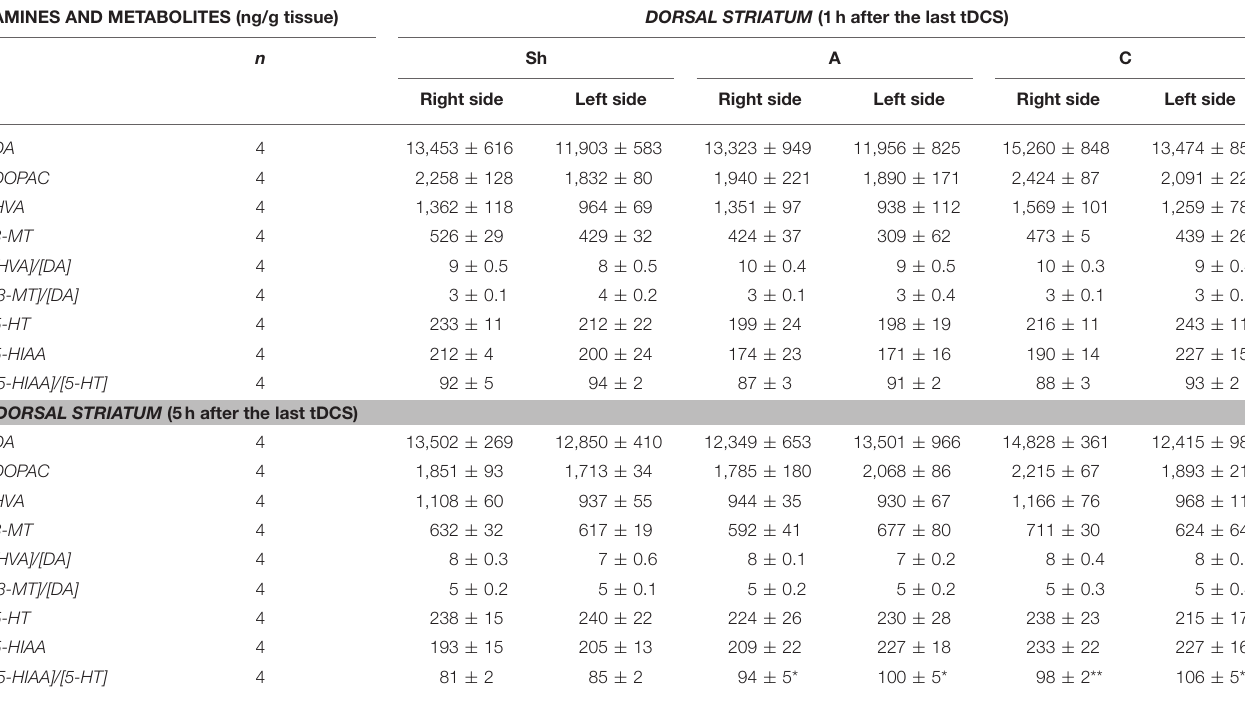
TABLE 5 | The effect of repetitive anodal (A) and cathodal (C) tDCS on the concentration of monoamines (DA, and 5-HT), their metabolites and on the rate of metabolism at different time point after the last stimulation investigated in the right and left DORSAL STRIATUM. AMINES AND METABOLITES (ng/g tissue) DORSAL STRIATUM (1h after the last tDCS) n Sh A C Right side Left side Right side Left side Right side Left